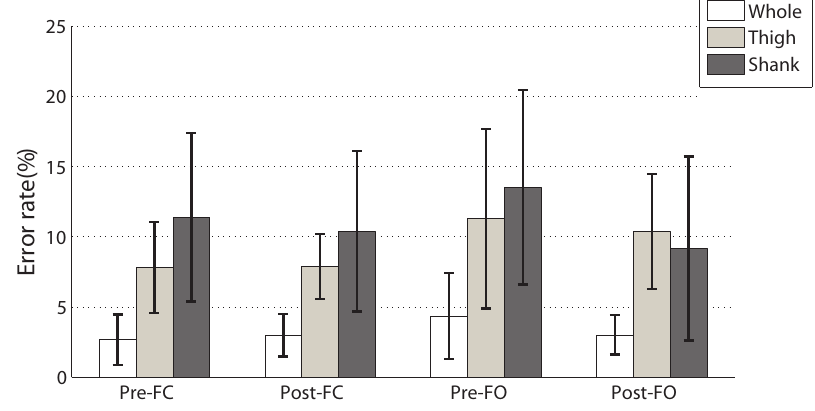
Figure 6. Classification errors of different combinations of signal channels. The results are obtained by LDA classifier with 200 ms window size. Data are obtained from twelve able-bodied